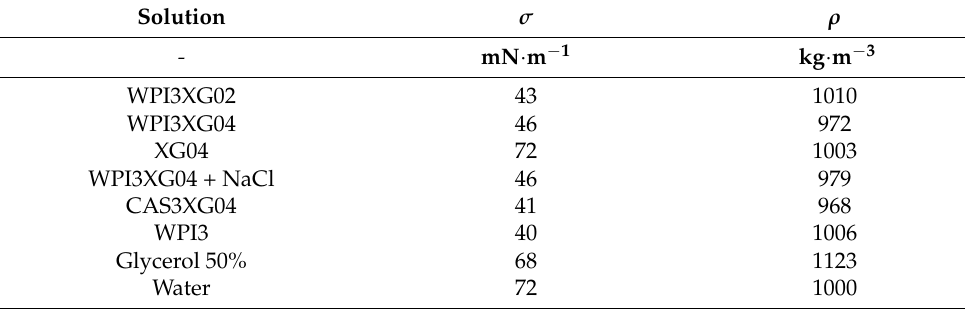
Table 1. Physico-chemical properties of solutions at 20 ◦